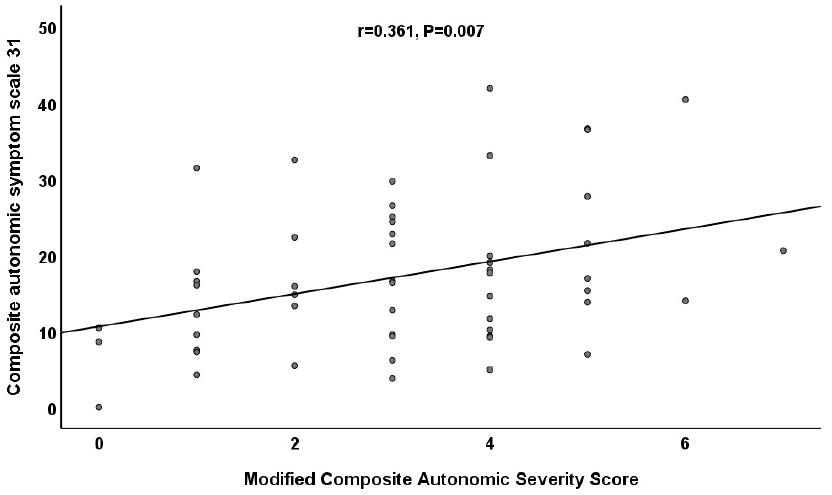
Figure 1. The correlation between the total weighted score of COMPASS 31 and the modified CASS. Patients with and without AN Based on Different CASS Scoring Systems When we added the Sudoscan-based sudomotor subscore, the case numbers for auto- nomic neuropathy (AN) increased from 22 (40%, CASS subscores) to 40 (72.7%, modified CASS). The clinical scores, the COMPASS 31 scores, and the cardiovascular autonomic function between patients with and without modified CASS-based AN are listed in Table 4. As for the COMPASS 31 scores, the orthostatic intolerance score and the total weighted COMPASS score were significantly different between the two groups ( p = 0.031 and p = 0.003, respectively). The differences between HRDB, the ESC values for hands and feet, and the ESC cardiovascular autonomic neuropathy (CAN) risk scores also showed statistical significance between the groups ( p = 0.022, p = 0.002, p < 0.0001, and p = 0.028, respectively). The values of the VR and the BRS_VM were larger in the group without AN than with AN, but the difference was not statistically significant. Table 4. Comparison of baseline characteristics and parameters of autonomic function between AN and non-AN groups according to CASS subscores and modified CASS scoring system.